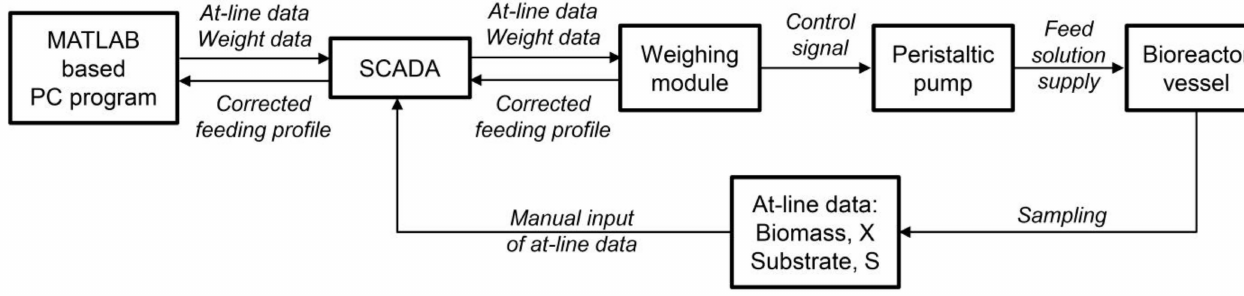
Figure 10. The communication scheme of a MATLAB-based MPC solution.